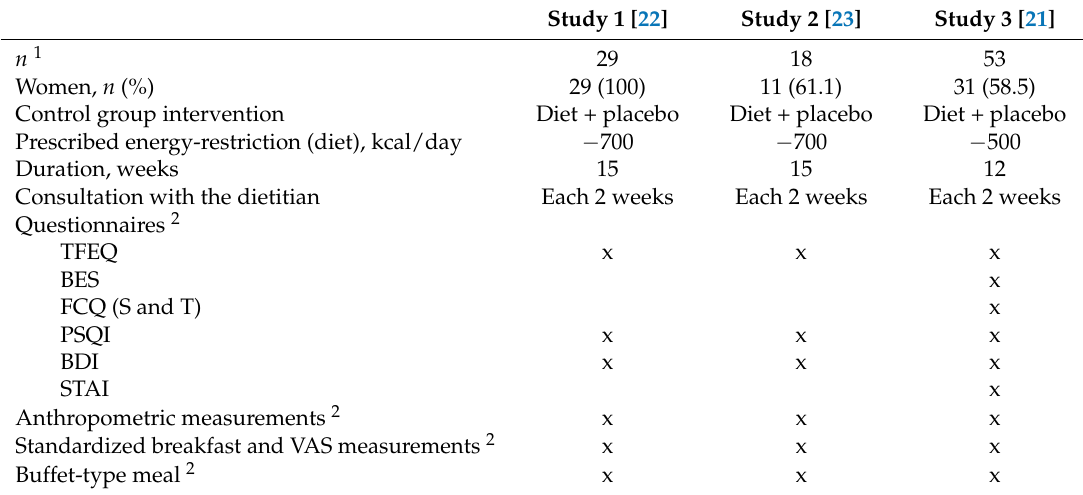
Table 1. Description of the three initial